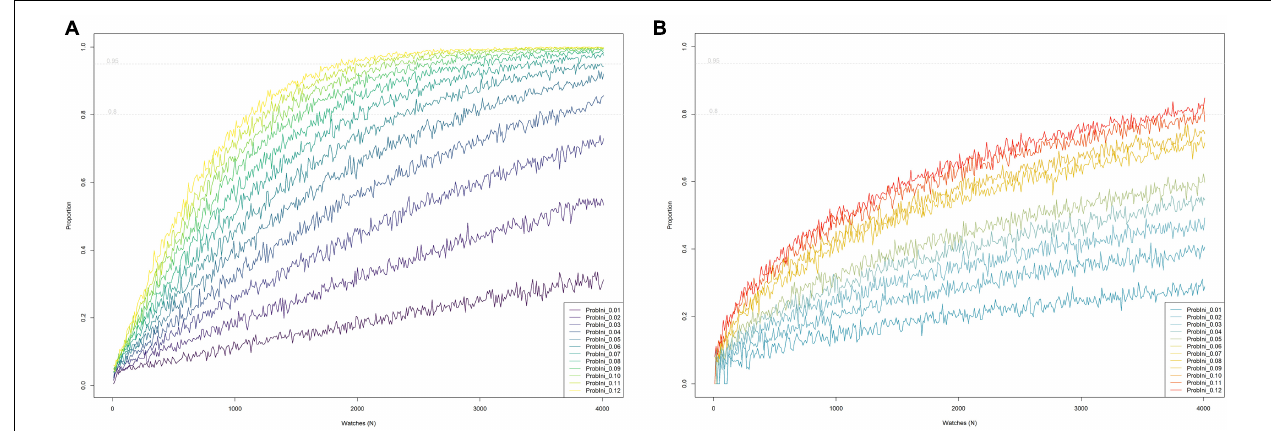
FIGURE 5 | The relationship between the annual number of watches (based on the notional approach of all these watches occurring at a single site with a known underlying initial sighting rate) and the proportion of simulations during which “trend detection criteria” were met, given an overall decline in sighting rate of 30% over 6 years, for a range of values for initial sighting rates (i.e., a range of initial values for relative abundance). Dotted horizontal gray lines indicate where 80 and 95% detection success was achieved. (A) Using the criterion that a statistically significant decline is detected (regardless of the estimated regression slope). (B) Using the criterion that the estimated regression slope is equivalent to a decline equal to or greater than the true underlying rate of decline over 6 years (in this example 30%), applying a tolerance limit of 20%. Thus the estimated slope must be equivalent to a decline of at least 24% over 6 years (since 20% of 30% is 6% and 30–6% =